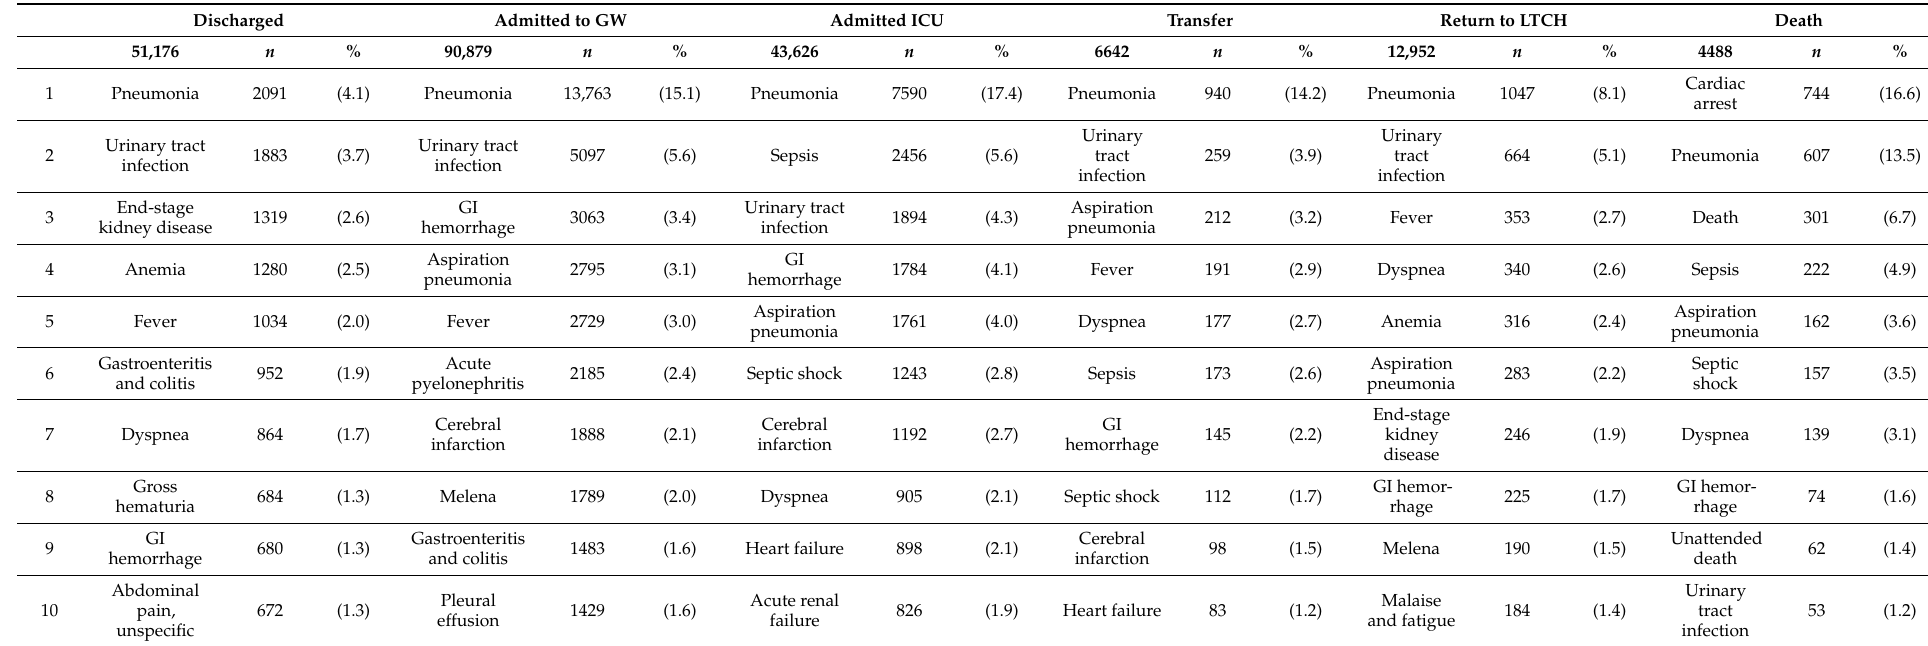
Table A1. Comparison of common diagnosis by ED disposition results of LTCH